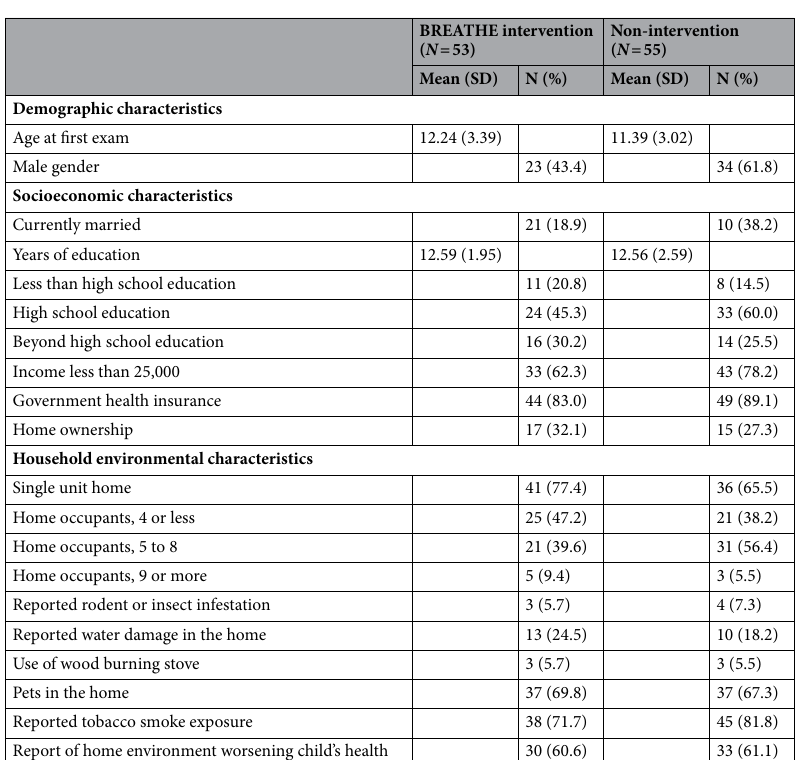
Table 1. Baseline demographic, socioeconomic, and household environmental characteristics by group status.